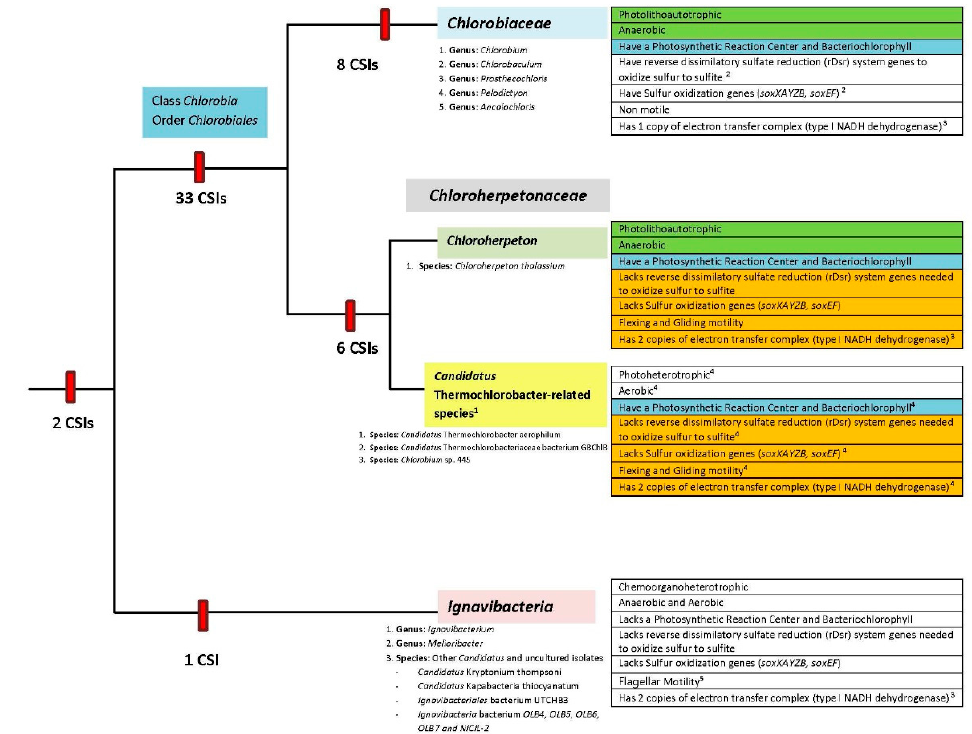
Figure 9. A conceptual diagram summarizing the evolutionary relationships among members of the phylum Chlorobi based on phylogenetic analysis and specific identified molecular signatures (synapomorphies). The numbers of CSIs that are specific for each clade or species-grouping are noted on the respective nodes. The species/genera present in each clade are listed underneath each label. The physiological and biochemical traits unique to each clade are listed on the right-hand side of the figure. Other notes: 1 These species have yet to be isolated and grown in pure culture; 2 Chlorobium ferroxidans is the sole exception; 3 Subunits NuoEFG missing from the sole copy in all Chlorobiaceae (11 subunits); Chloroherpeton thalassium NuoEFG missing from only one copy (14 and 11 subunits); Candidatus Thermochlorobacter aerophilum (12 and 11 subunits); Ignavibacterium album (14 and 11 subunits); 4 Inferred from genome sequences of Chlorobium sp. 445, Candidatus Thermochlorobacter aerophilum, and Candidatus Thermochlorobacteriaceae bacterium GBChlB; 5 Observations by light and electron microscopy suggested that I. album was not motile and lacked flagella (Iino et al., 2010 [7]). However, the I. album genome contains a nearly complete set of genes for flagella along with genes for chemotaxis and signal transduction. Melioribacter roseus is motile only during exponential growth, using flagella to move through water, but loses its flagella and mobility during stationary growth.